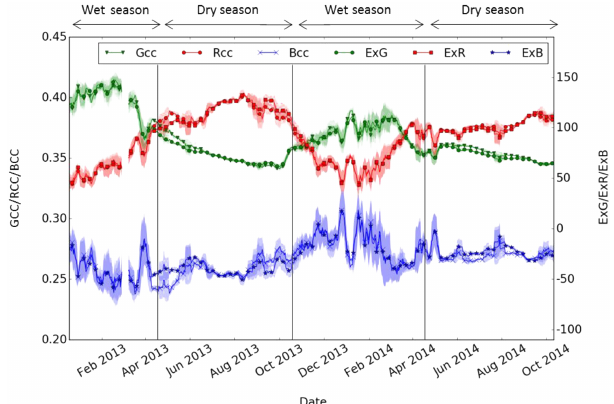
Figure 4. Daily green, red and blue chromatic coordinates (GCC– RCC–BCC) and excess indices (ExG–ExR–ExB) for the Howard Springs OzFlux site understory from December 2012 to Octo- ber 2014. Daily data are shown with an 8-day centred running mean (marked every 8 days for visualisation) applied. The standard error of the mean is given by the